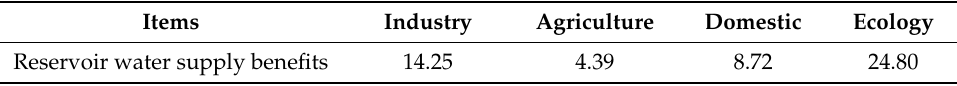
Table 7. Water supply benefits of various industries(10 8